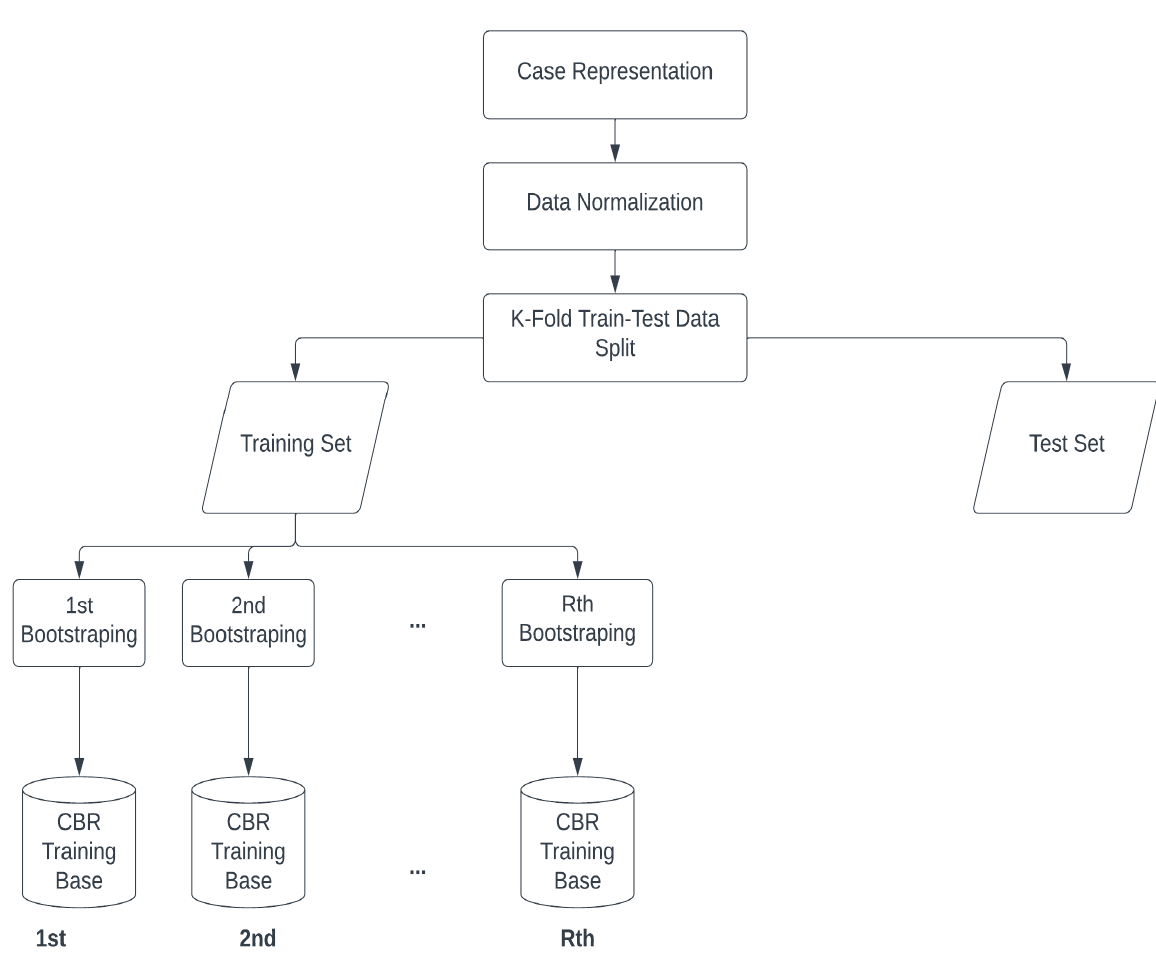
Figure 1. CBR-BSR Train-Test Split .